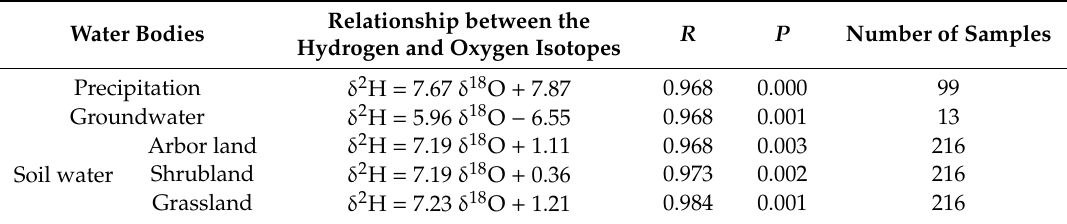
Table 2. The relationship between δ 2 H and δ 18 O in different water bodies.